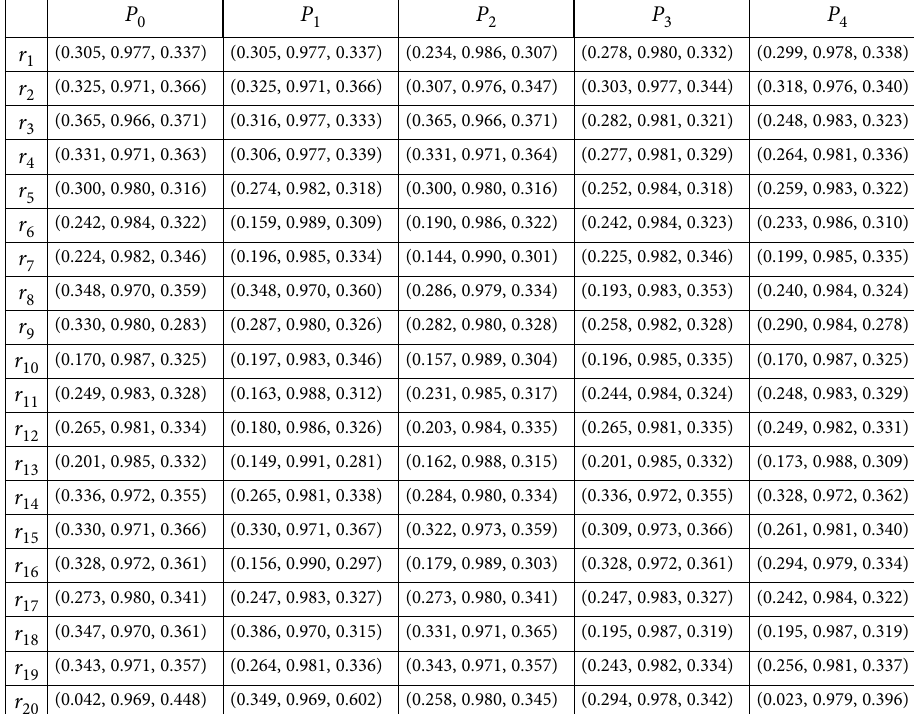
Table 7. WNA-q-ROF-DM for options over different IoT risks for SCM